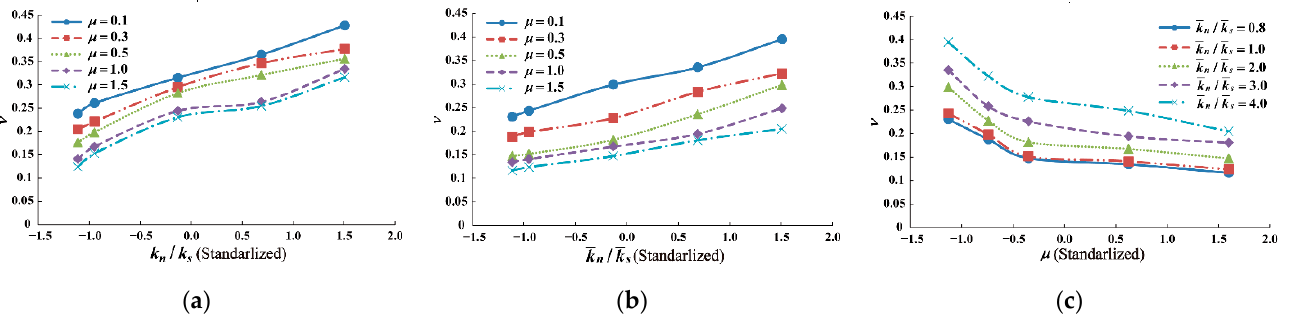
Figure 12. Joint effect of multiple meso parameters on Poisson’s ratio: ( a ) Particle and parallel bond stiffness ratios; ( b ) Parallel bond and particle stiffness ratios; ( c ) Friction coefficient and parallel bond stiffness